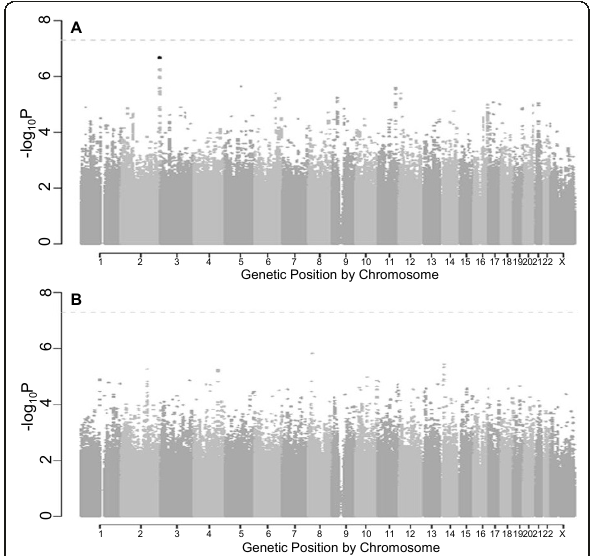
Figure 3 Renal sinus fat Manhattan plots for the genome-wide association analysis by sex . (a) Manhattan plot of results from the genome-wide association analysis of renal sinus fat in women, adjusted for age and BMI. The dotted line represents a -log p-value threshold of 5 × 10 -8 . (b) Manhattan plot of results from the genome-wide association analysis of renal sinus fat in men, adjusted for age and BMI. The dotted line represents a -log p-value threshold of 5 × 10 -8 .